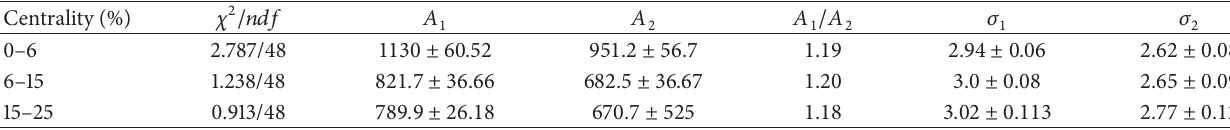
Table 2: PHOBOS Cu+Cu 200 GeV.